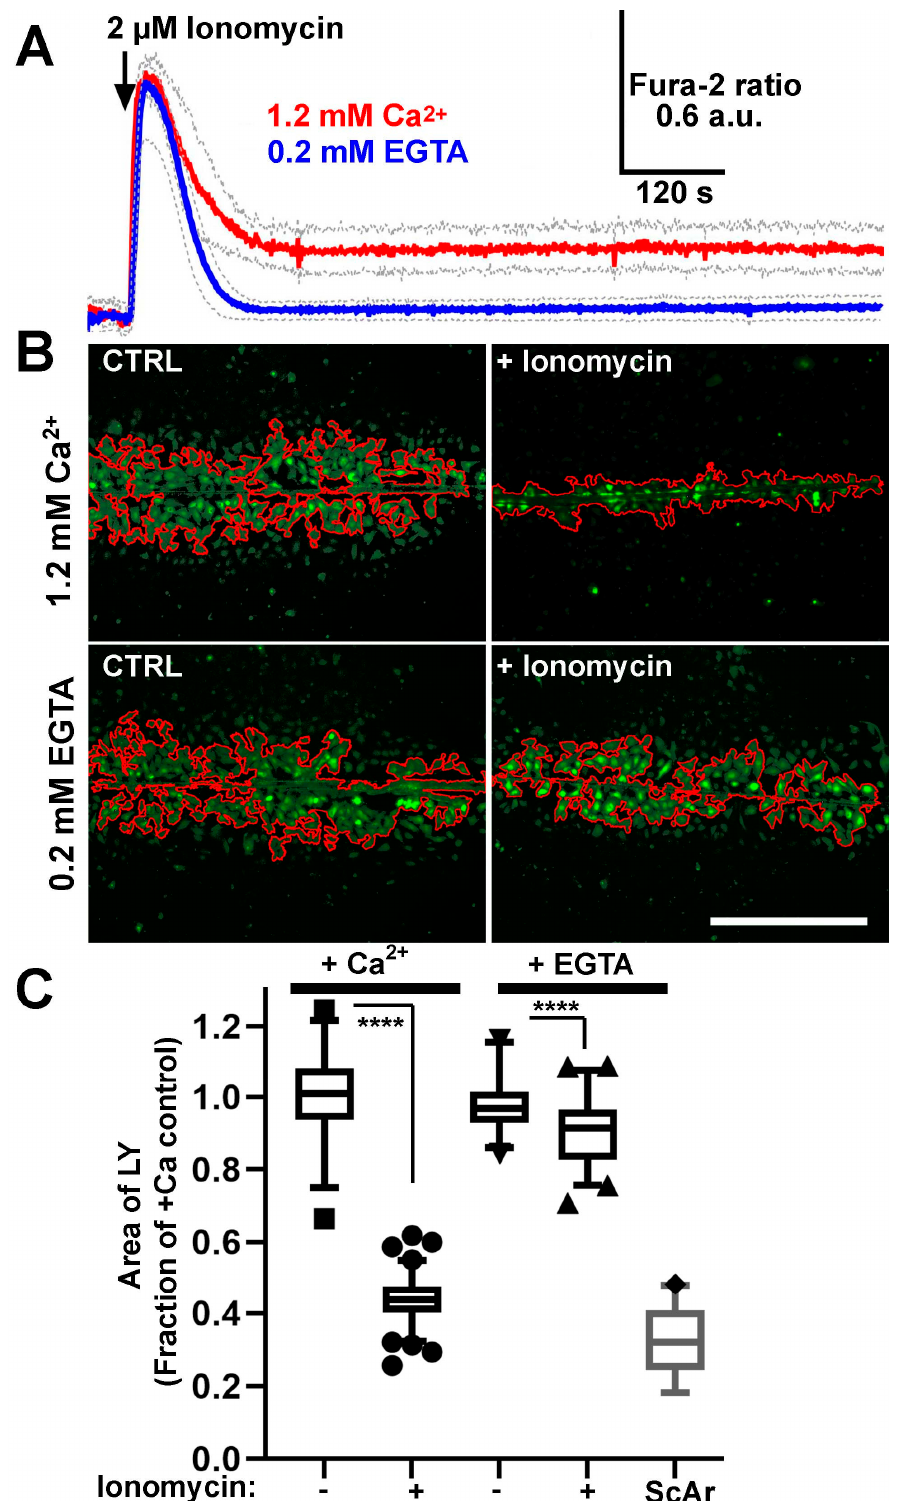
Figure 9. Ca 2+ -inhibition of gap junction coupling in HUVEC. ( A ) changes in 340/380 nm fura-2 fluorescence ratio (a.u. stands for arbitrary units) in HUVEC during stimulation with ionomycin (2 µ M) in the presence or absence of external Ca 2+ , as indicated. Solid lines are the mean of 9 (plus Ca 2+ ; red) and 11 (minus Ca 2+ ; blue) cells, grey dashed lines show the 95% confidence